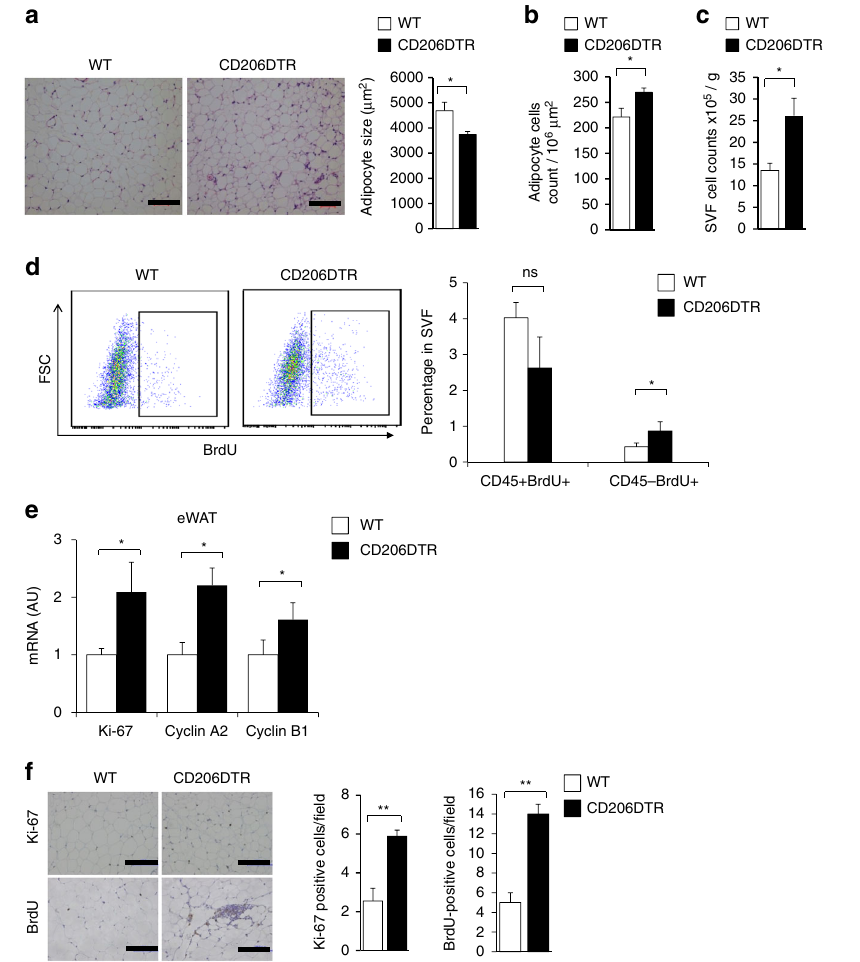
Fig. 2 Depletion of CD206 + ATMs induces generation of smaller adipocytes. a Representative sections of eWAT from WT and CD206DTR were stained with hematoxylin and eosin (HE) ( left panel ) and adipocyte size ( right panel ); Scale bar, 100 μ m. b Cell count measurements in the eWAT. c Cell count of SVF obtained from eWAT of DT-treated WT and CD206DTR mice ( n = 4 – 5 mice per group). d Representative fl ow cytometry analysis of BrdU + cells in CD45 − SVF from WT and CD206DTR mice ( left panel ). Percentages of CD45 + /BrdU + and CD45 − /BrdU + fractions in SVF from WT and CD206DTR mice were calculated ( right panel ) ( n = 4 – 5 mice per group). Full gating strategy is given in Supplementary Fig. 5e. e Relative mRNA expression of cell cycle and proliferating marker genes in the eWAT ( n = 4 – 7 per group). f Representative paraf fi n eWAT sections of Ki-67 immunostaining counterstained with eosin ( bluish ) ( upper panel ), and BrdU uptake ( lower panel ). Scale bar, 100 μ m. Quanti fi cation (right panel; n = 3 – 6 per group). The data are shown as the means ± SEM. * P < 0.05, ** P < 0.01, ns = non-signi fi cant compared with littermates by Student ’ s